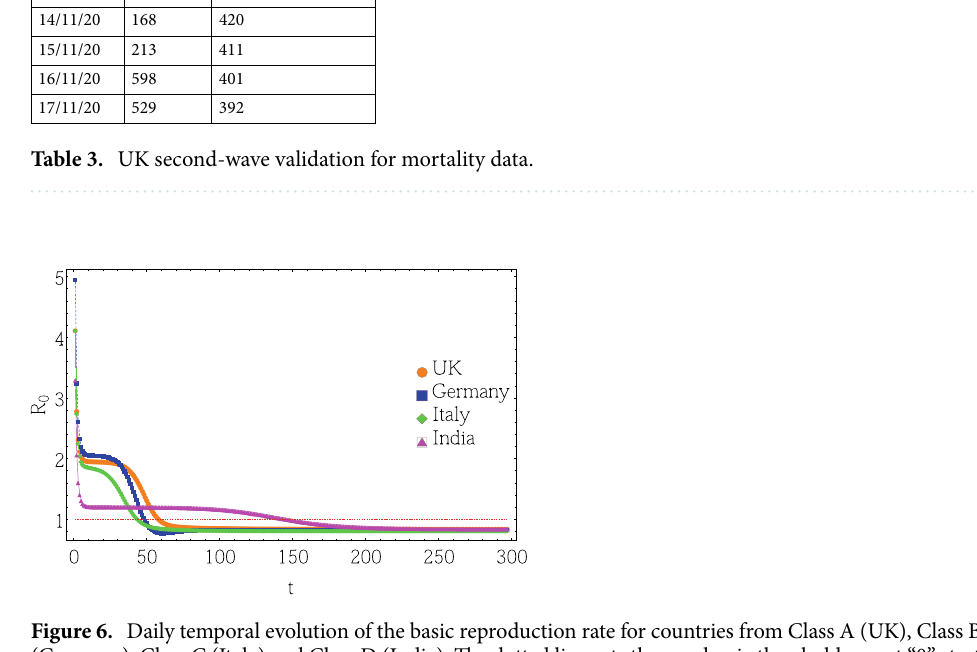
Figure 6. Daily temporal evolution of the basic reproduction rate for countries from Class A (UK), Class B (Germany), Class C (Italy) and Class D (India). The dotted line sets the pandemic threshold; count “0” starts